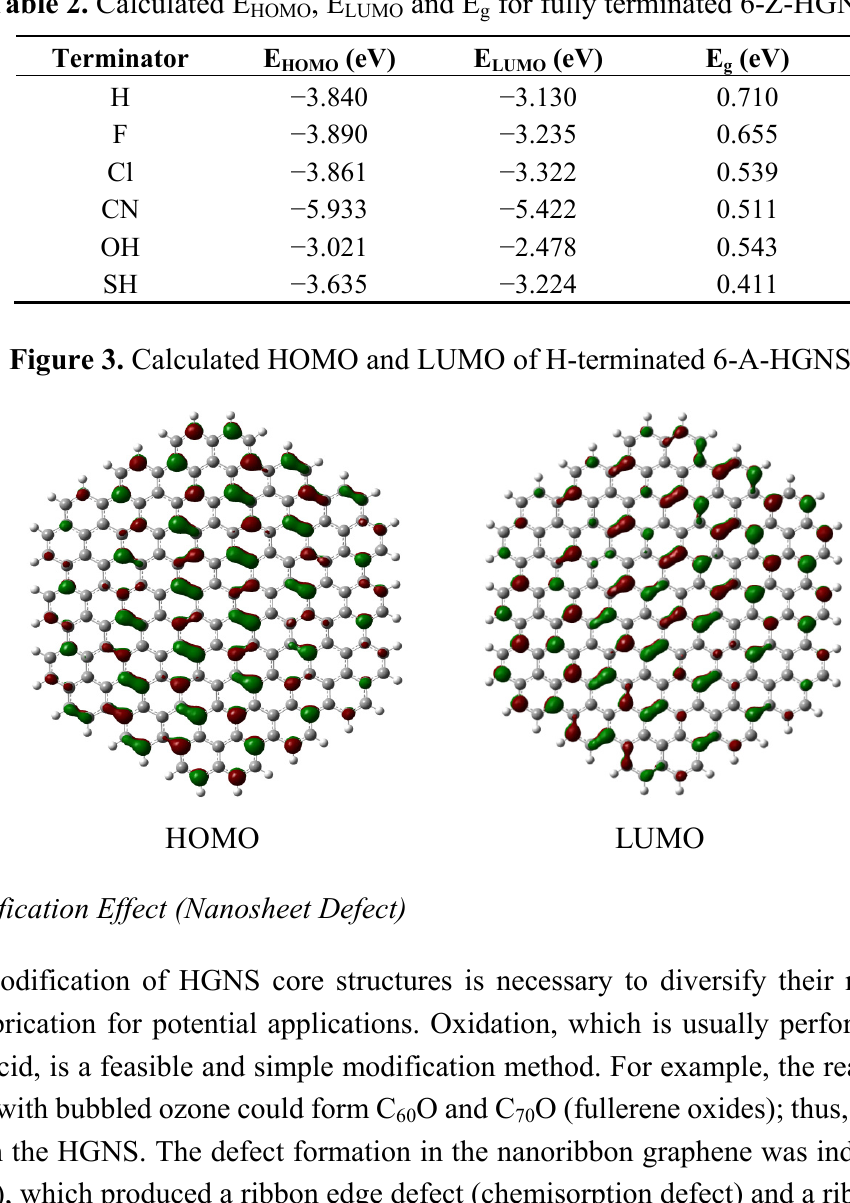
Table 2. Calculated E